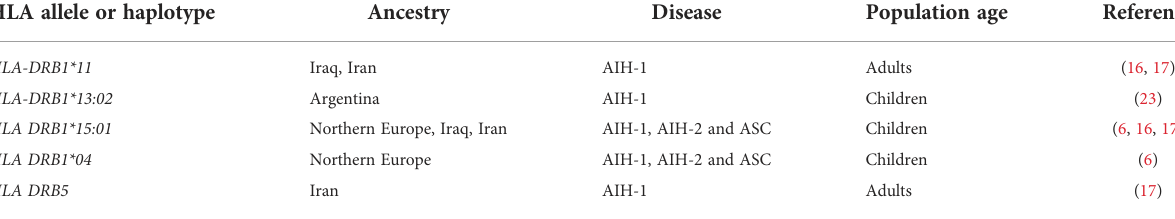
TABLE 2 HLA alleles protective from autoimmune